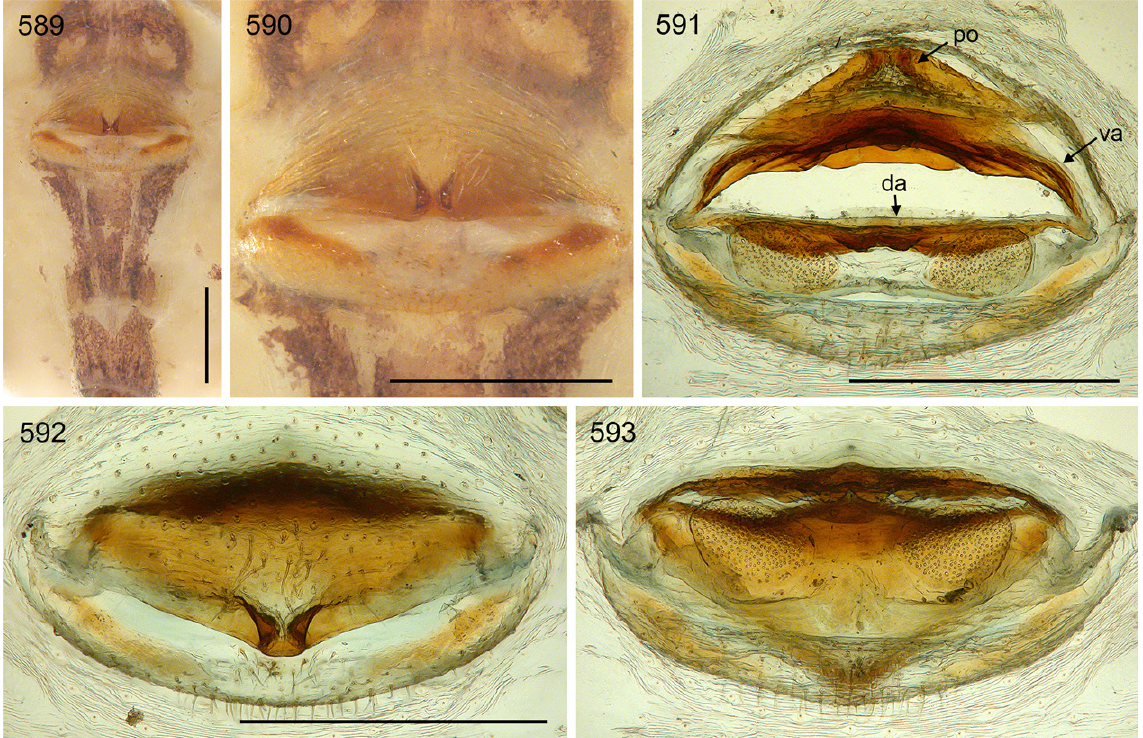
Figs 589–593. Crossopriza semicaudata (O. Pickard-Cambridge, 1876); female from Egypt, 5 km N of Aswan (CAS 9027139). 589–590 . Abdomen and epigynum, ventral views. 591–593 . Female internal genitalia, dorsal view (with dorsal arc tilted backwards and epigynal plate accidentally flipped forward), ventral view, and regular dorsal view. Abbreviations: da = dorsal arc; po = pocket; va = ventral arc. Scale bars = 0.5